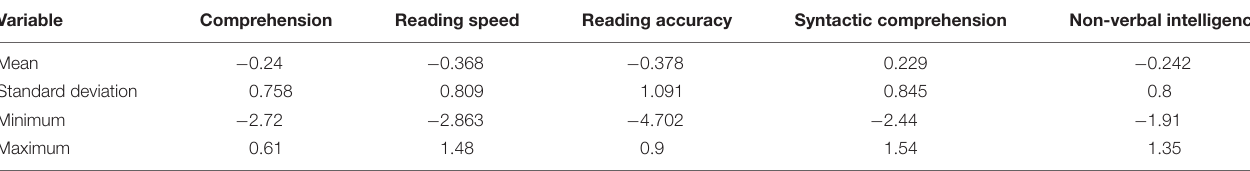
TABLE 1 | Means, standard deviations and range values for Comprehension, Reading fluency, Reading accuracy, Syntactic comprehension, and Non-verbal intelligence.